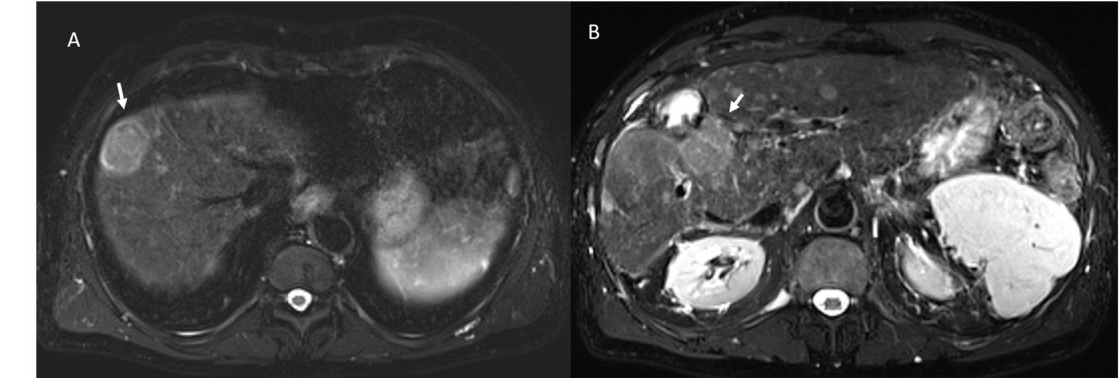
Figure 3. The same patient of Figure 2: in pre-treatment SPACE FS T2-W sequence ( A ), the lesion shows hyperintese SI; in post-treatment SPACE FS T2-W sequence ( B ), viable lesion shows hypeintense SI.